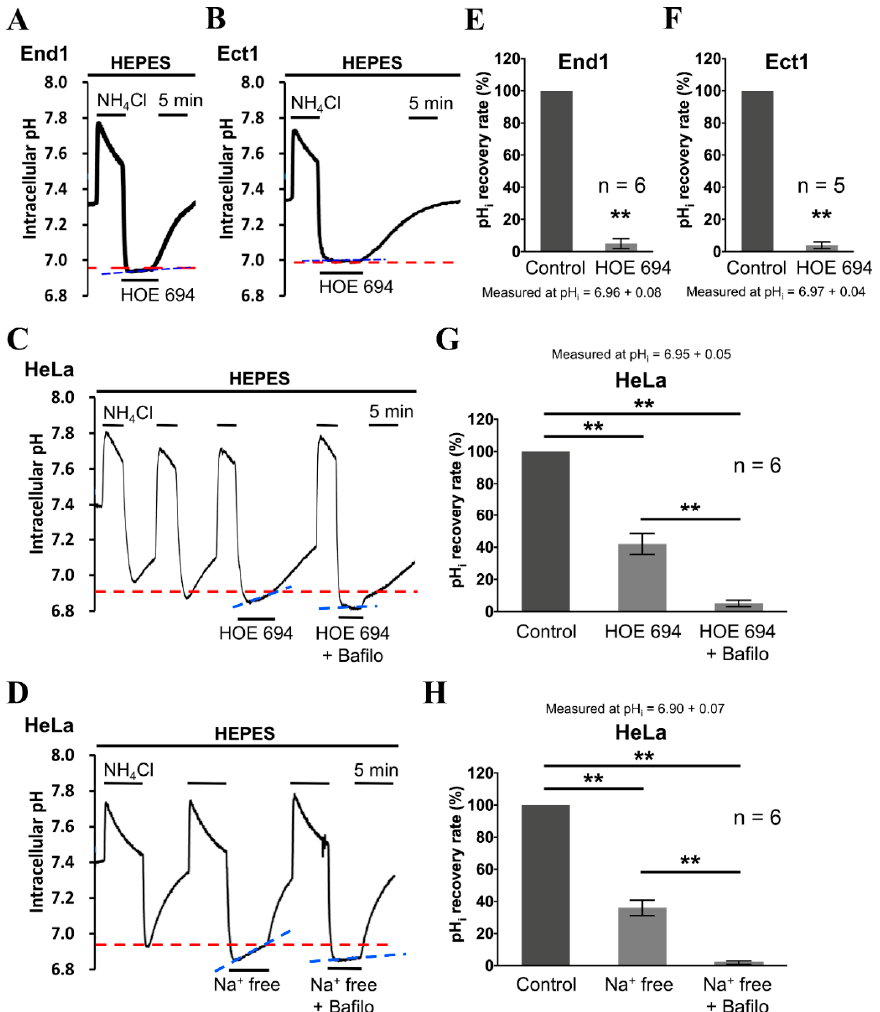
Figure 3. Effect of Na + -free solution, HOE 694, Na + -free solution plus bafilomycin A1 (Balifo), and HOE 694 plus bafilomycin A1 (Balifo) on intracellular pH (pH i ) recovery subsequently induced intracellular acidification in HEPES-buffered condition. ( A – D ) The top headings show the cells used, and the bars above or below the trace show the application of NH 4 Cl and treatment. The first part of trace A – D shows a typical pH i recovery from an induced intracellular acidification in HEPES-buffered solution as control. The other part shows the pH i recovery slope after application of di ff erent design conditions, i.e., Na + free, HOE 694, Na + -free solution plus bafilomycin A1 (Balifo), and HOE 694 plus bafilomycin A1 (Balifo), respectively. ( E – H ) Histogram shows the normalization of pH i recovery rate of acid extrusion that are averaged for 5–6 experiments similar to those shown in A – D , respectively. The pH i recovery rate measured is shown at the top of the histogram, and ** p < 0.005 versus the control. Error bars represent the mean ± SEM (standard error mean).